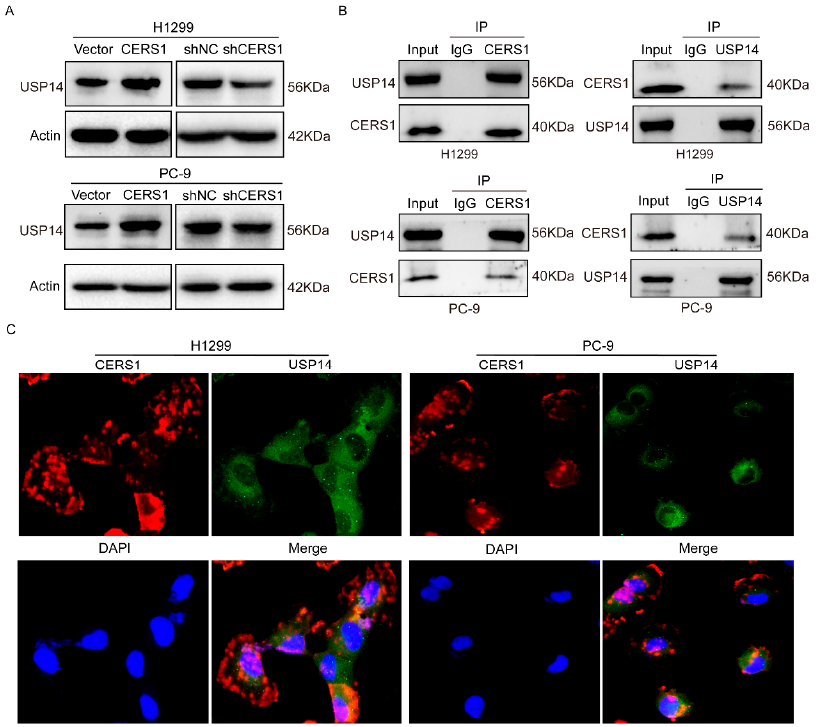
Figure 3. Interaction between CERS1 and transcription factor USP14. ( A ) Expression of indicated proteins was evaluated using western blo tt ing. ( A ) USP14 expression following CERS1 knockdown was detected using western blo tt ing. ( B ) Co-IP demonstrated an interaction between CERS1 and USP14. ( C ) Immuno fl uorescence was performed to detect CERS1 and USP14 localization in cells.